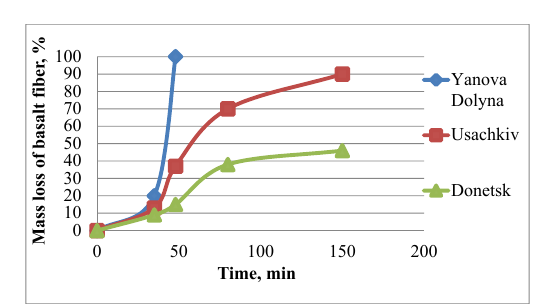
Fig. 2. The total mass loss of basalt fiber in etching solutions